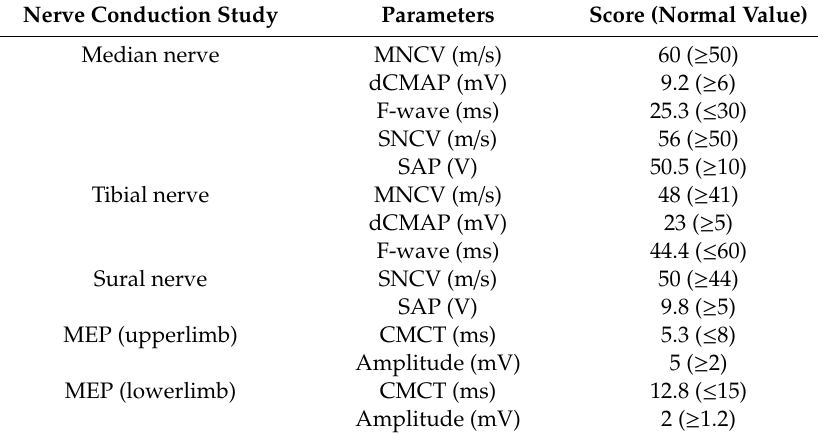
Table 3. Neurophysiological study performed on